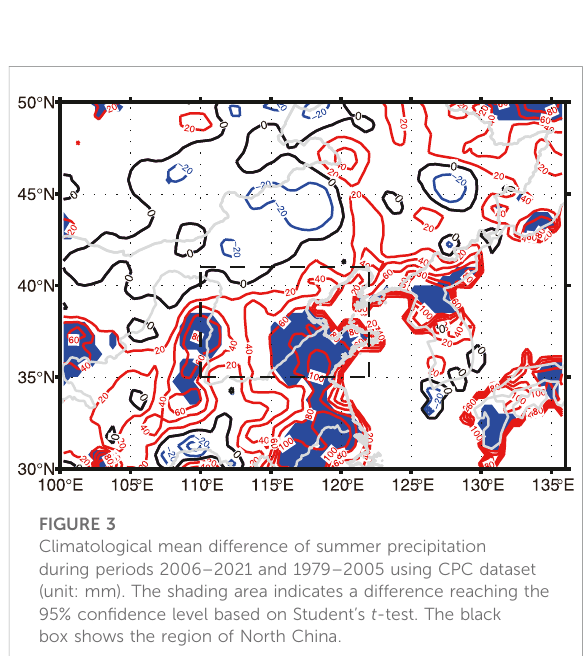
FIGURE 3 Climatological mean difference of summer precipitation during periods 2006 – 2021 and 1979 – 2005 using CPC dataset (unit: mm). The shading area indicates a difference reaching the 95% con fi dence level based on Student ’ s t -test. The black box shows the region of North